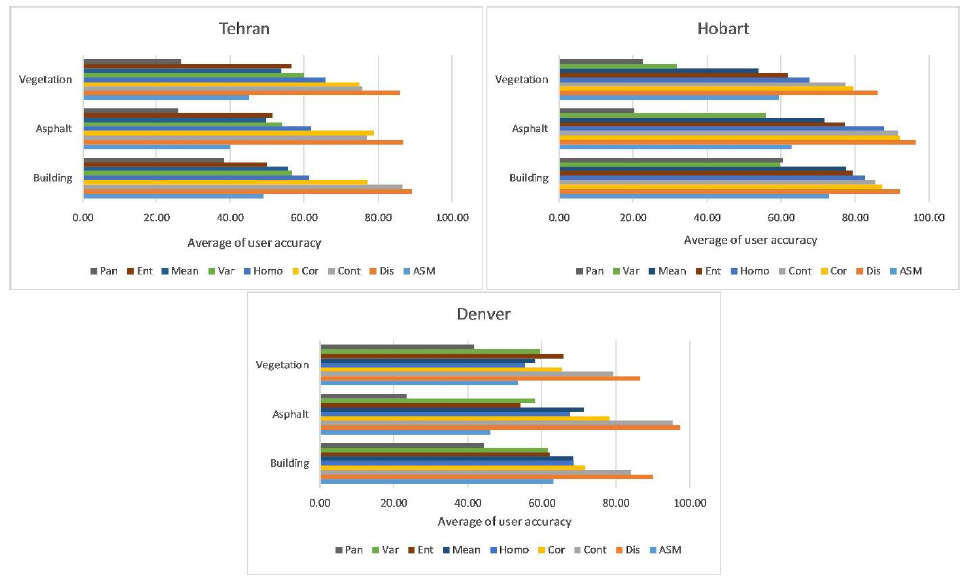
Figure 7. The individual evaluation of each input feature in the classification performance .